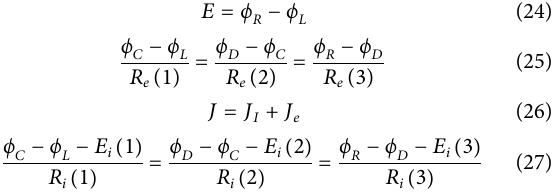
cathode. Point C is the contact site between the second layer and the fi rst layer of the electrolyte. Point D is the contact site between the third layer and the second layer of the electrolyte. Point R is the contact site between the anode and the third layer of the electrolyte.